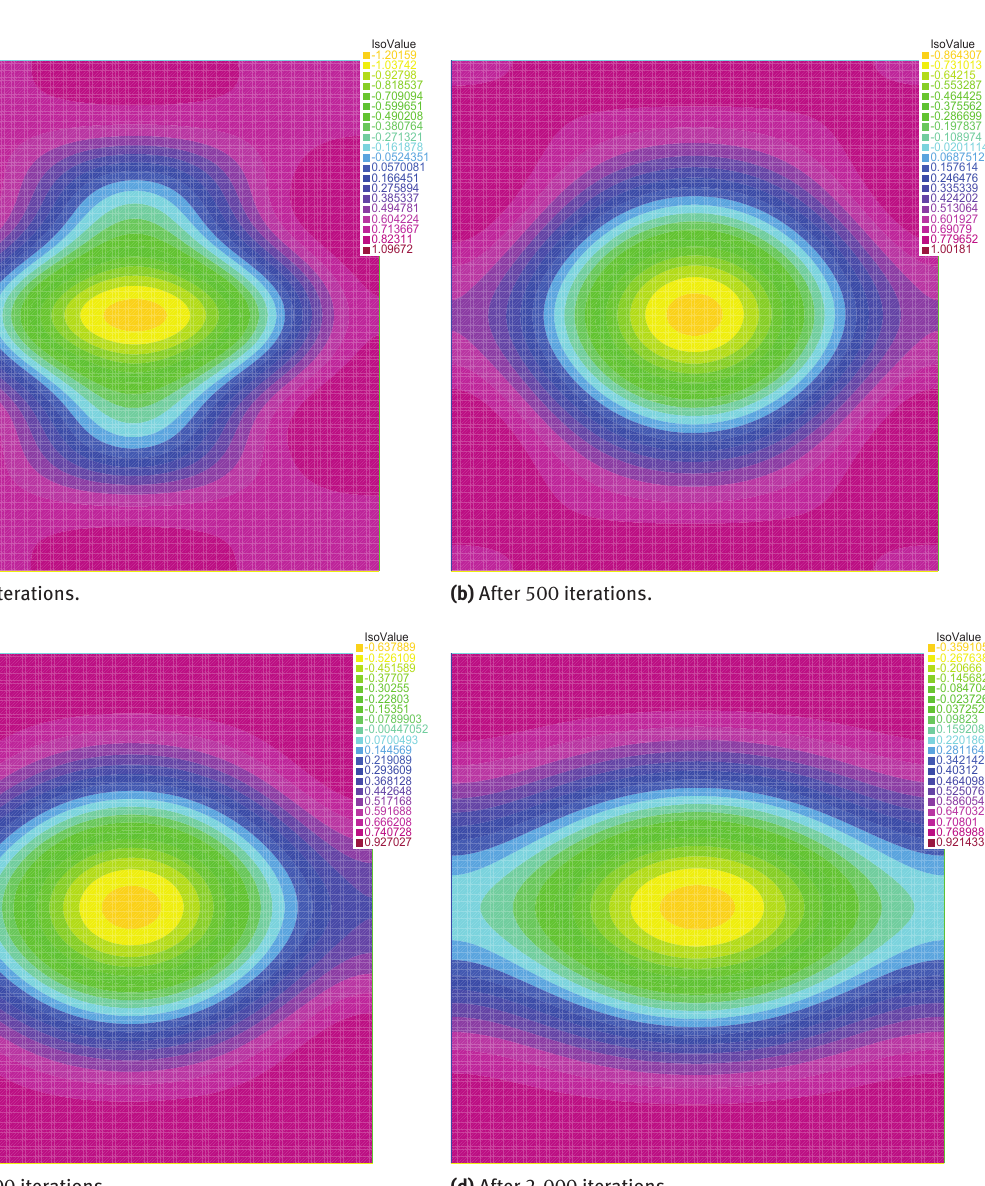
Figure 10: Results for k = 3, dt = 10 − 8